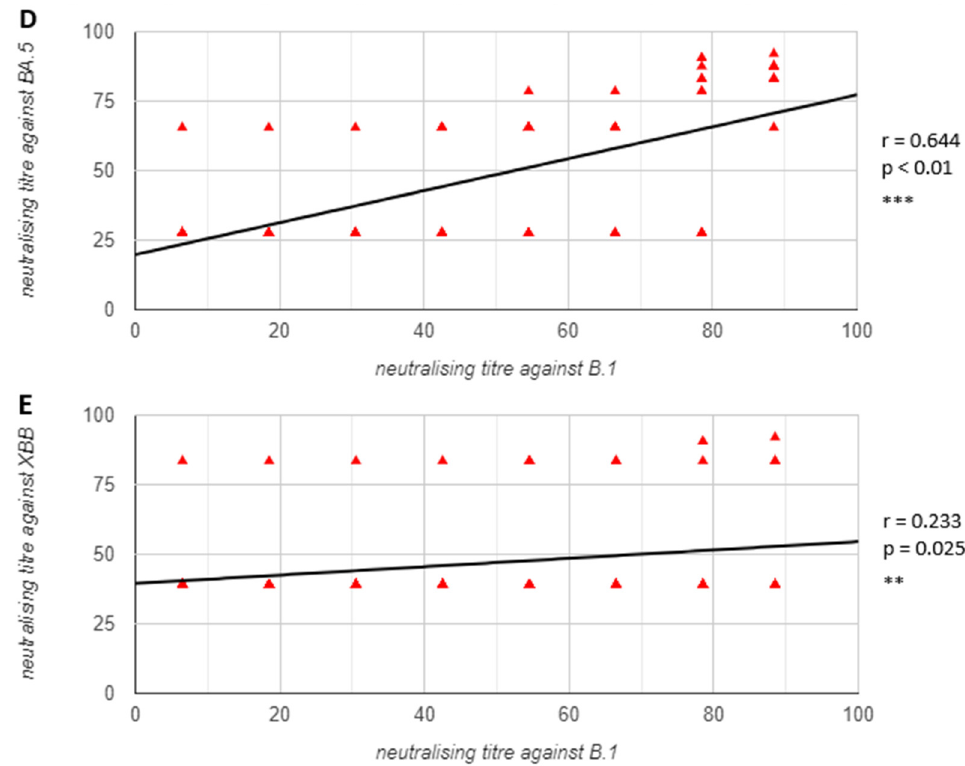
Figure 3. Correlation between anti-S1/S2 IgG values and neutralisation titres against ancestral strain B.1 and mutated lineage B.1.1.529 BA.5 and recombinant XBB, separately, as shown in panels ( A ), ( B ) and ( C ), respectively. Correlation between neutralising titre against lineage B.1 and both mutated variants was also analysed (panel ( D ) for B.1-BA.5 correlation and panel ( E ) for B.1-XBB correlation). Statistical correlation was tested using a non-parametric two-tailed Spearman’s rank correlation. Results r values and p values are reported in each graph (*** p < 0.01, ** p < 0.05).